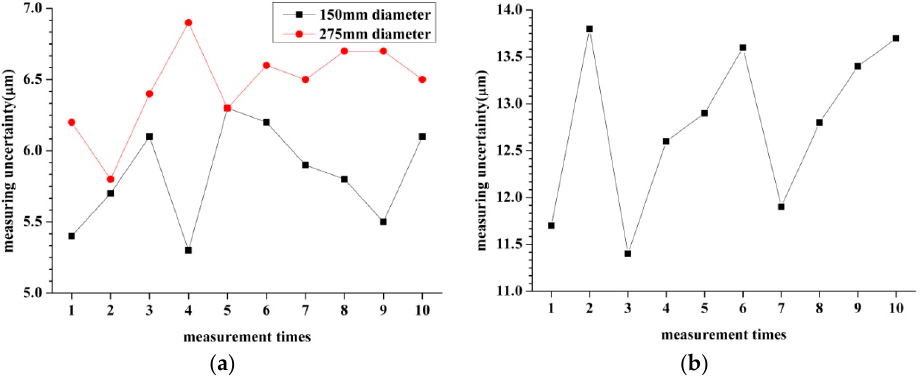
Figure 11. The influence of the installation pose to the measurement results. ( a ) The influence of the installation pose when measuring inner diameters; ( b ) The influence of the installation pose when measuring the hole–center distance. measuring the hole–center